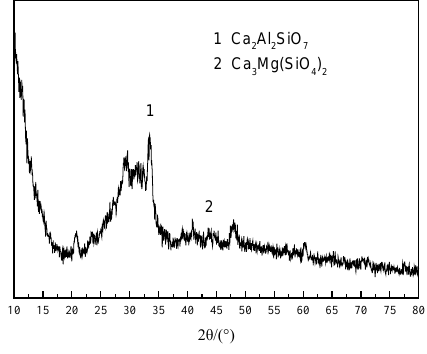
Figure 2. XRD patterns of GGBS.